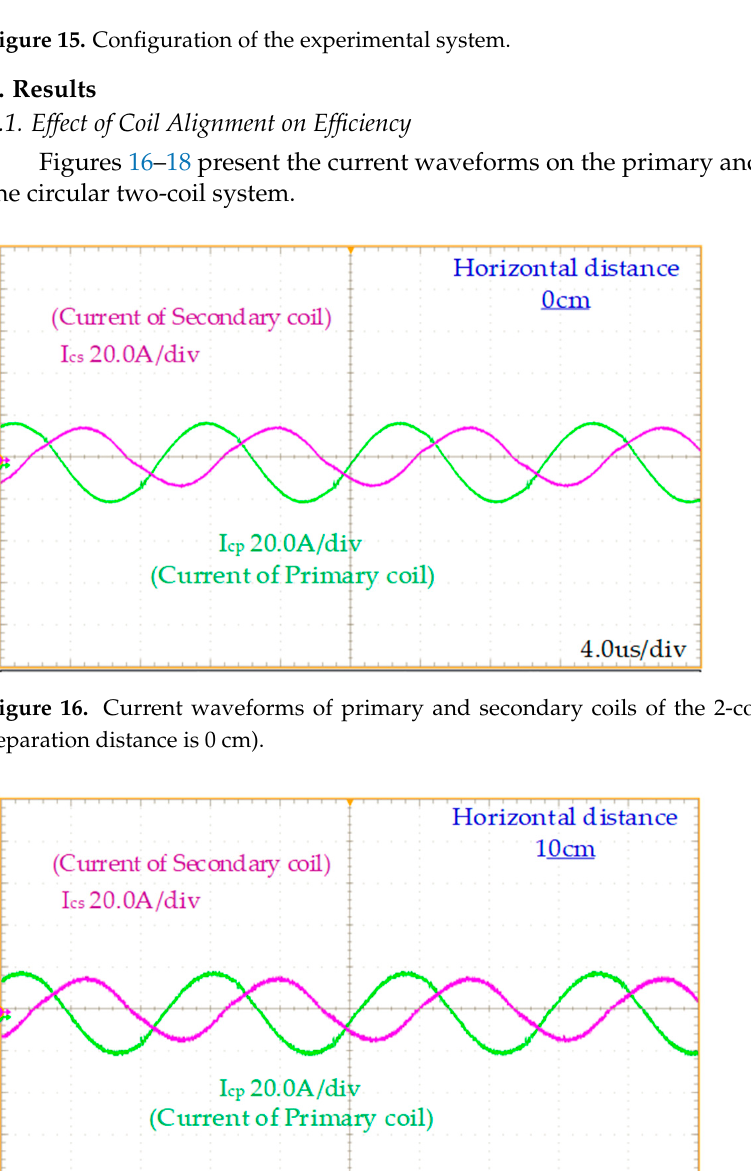
Figure 17. Current waveforms of primary and secondary coils of the 2-coil system (horizontal separation distance is 10 cm).